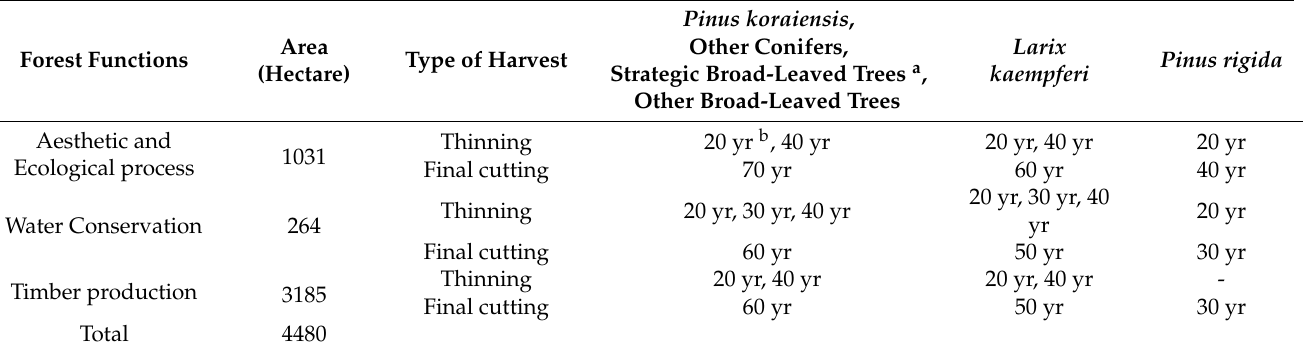
Table 4. Prescription scenarios by forest functions and species, for which timings (year) of thinning and final cutting are presented.